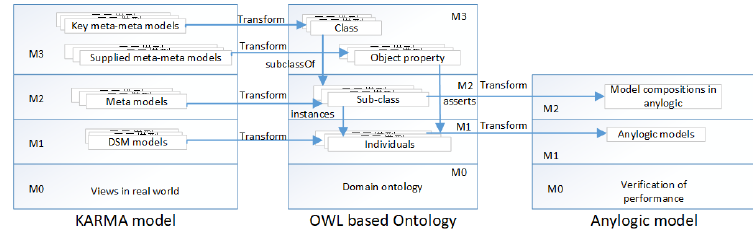
Figure 8. From architecture model to AnyLogic model.